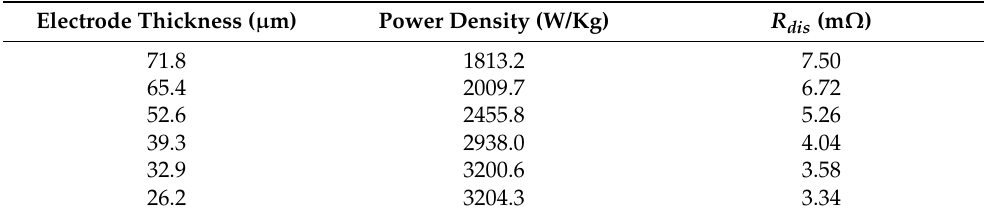
Table 5. The power density and DC internal resistance R dis of the cell.